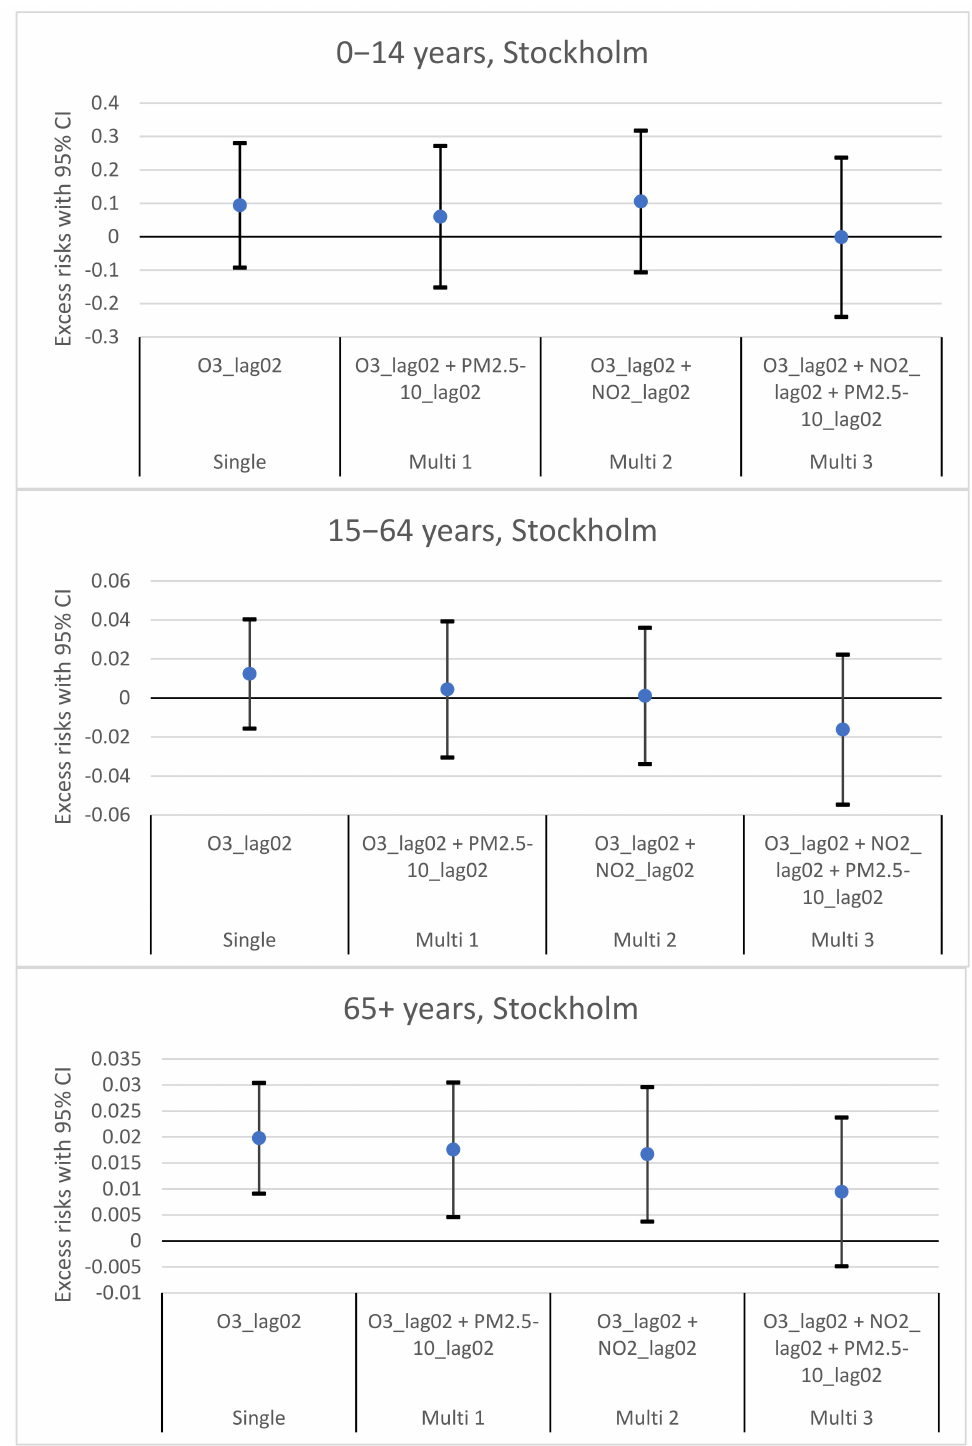
Figure 5. Multi-pollutant models of the estimated change in daily mortality in different age groups (with 95% CI) for an IQR increase in the concentration of O 3 (lag02) in Stockholm. From left to right: a single-pollutant estimate of O 3 (Single), O 3 adjusted for PM 2.5–10 (Multi 1), O 3 adjusted for NO 2 (Multi 2), and O 3 adjusted for both NO 2 and PM 2.5–10 (Multi